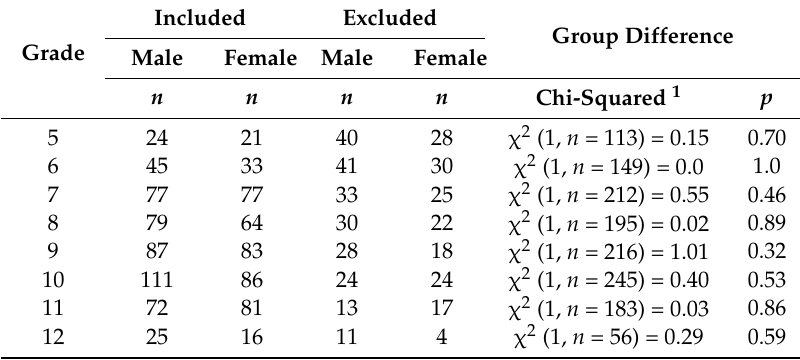
Table A2. Difference in gender between included and excluded respondents by grades.